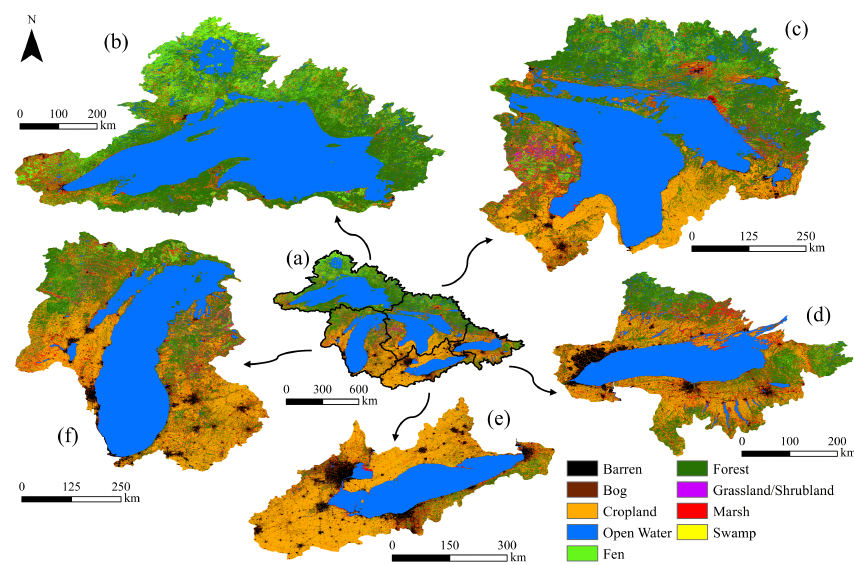
Figure 7. Generated wetland map of the ( a ) Great Lakes and ( b – f ) its subbasins (i.e., Lake Superior, Lake Huron, Lake Ontario, Lake Erie, and Lake Michigan, respectively) using satellite imagery between 2020 and 2021 as the reference time interval.